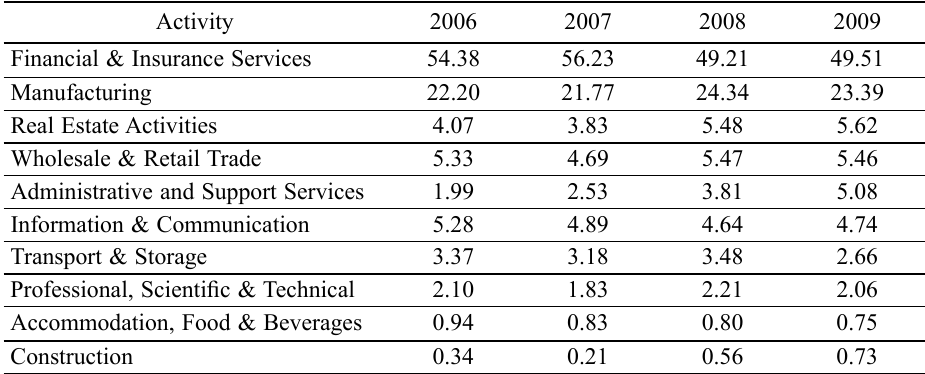
Table 3. Singapore’s OFDI by activity (% share), 2006−2009